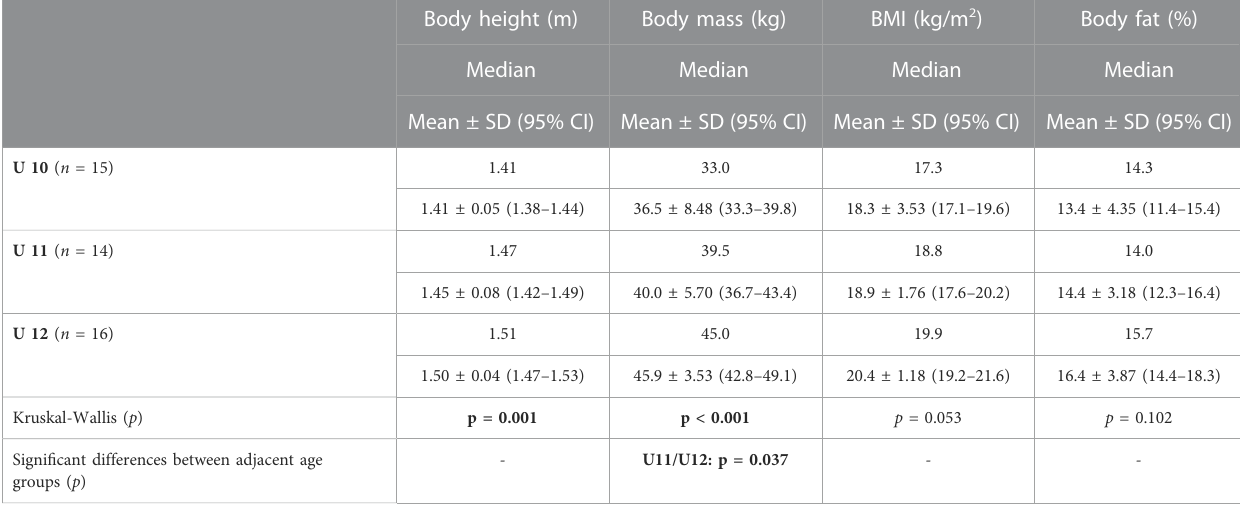
TABLE 2 Demographic and anthropometric characteristics in relation to age groups.